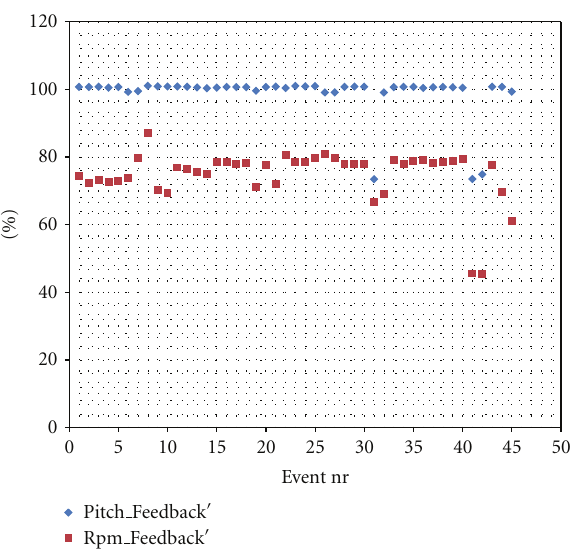
Figure 22: Propeller pitch and rpm feedback during the events— port unit.